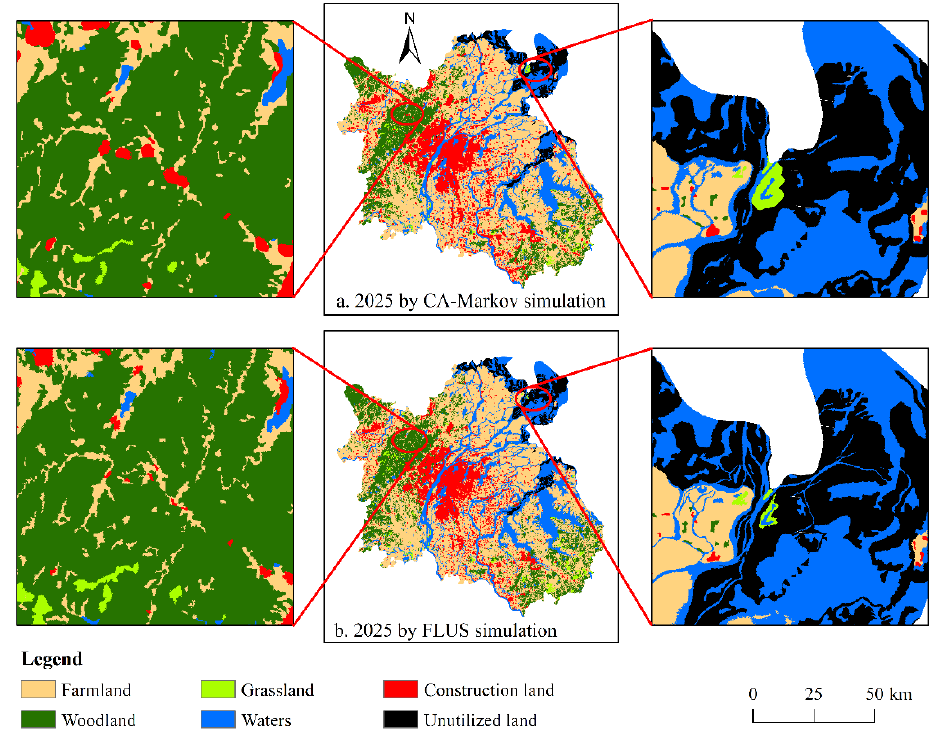
Land 2021 , 10 , x FOR PEER REVIEW Figure 7. Spatial distribution patterns of land ‐ use types in 2025 projected by CA ‐ Markov and Figure 7. Spatial distribution patterns of land-use types in 2025 projected by CA-Markov and FLUS. FLUS.